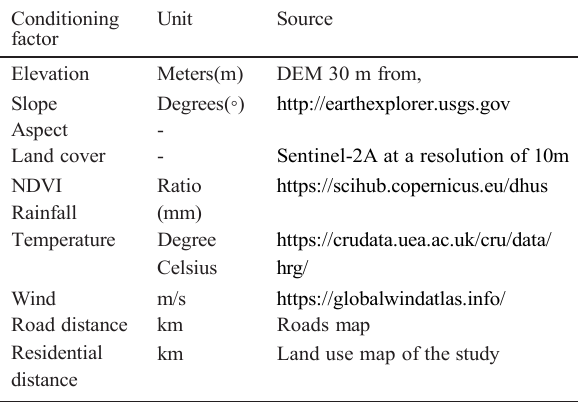
Table 3. Explanatory factors used in this